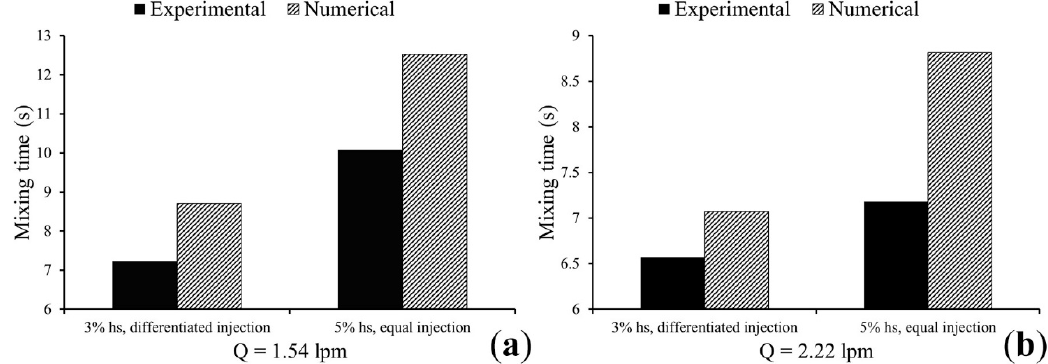
Figure 10. Effect of the gas flow rate on the mixing time predicted by the model and experimental measurements for ( a ) low gas flow and ( b ) differentiated gas flow.